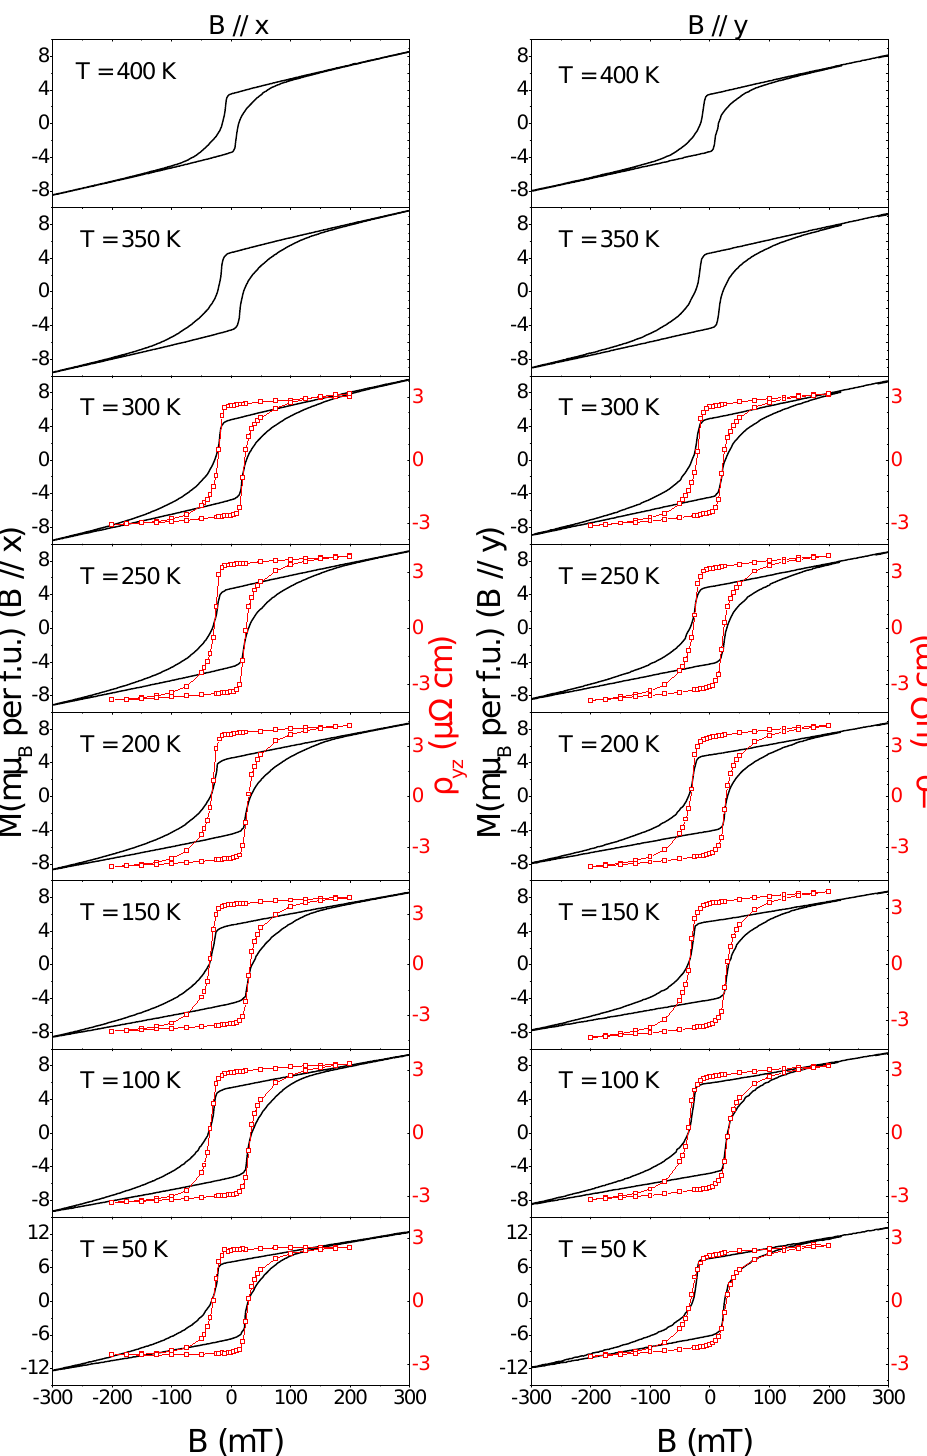
Figure S1: The magnetization and Hall resistivity with the magnetic field along x (left column) and y (right column) axes at different